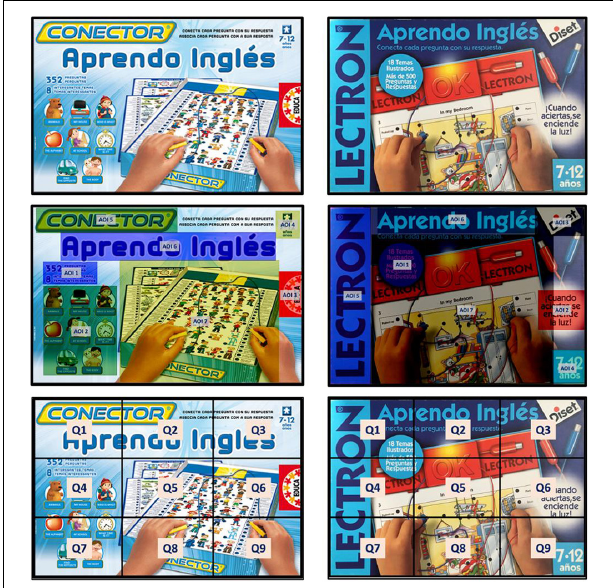
FIGURE 1 | Packaging, areas of interest, and design quadrants. Source: Prepared by the authors.